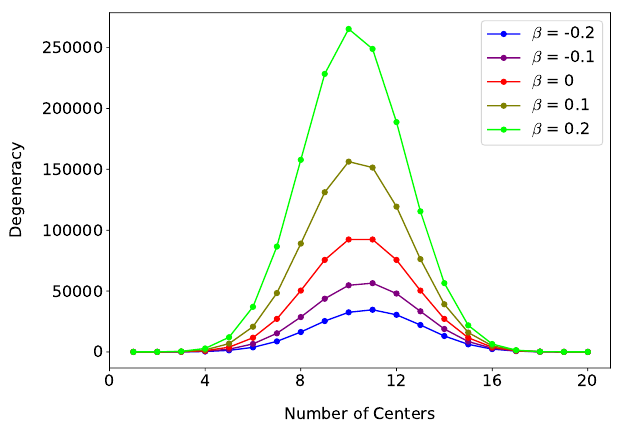
} ) versus N for a range of values of β , with α = 1 i